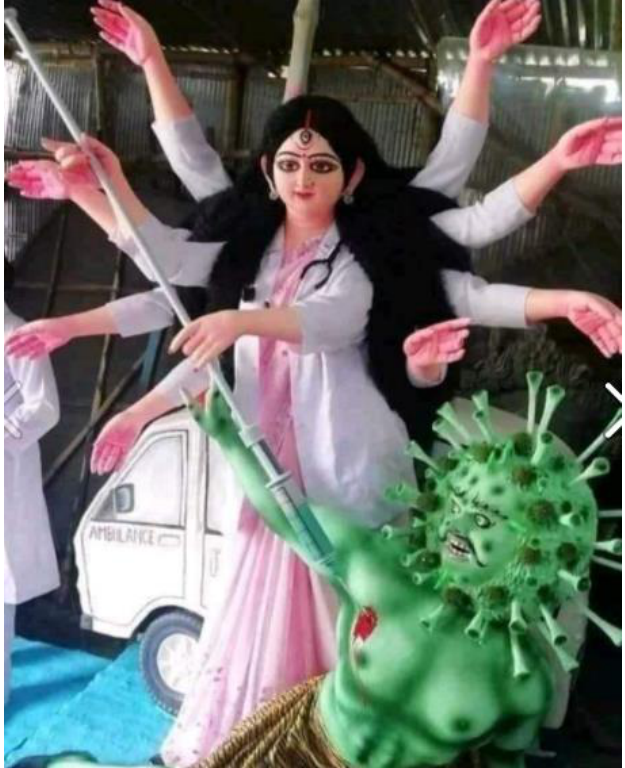
Figure 2. Mahi ṣ āsurmardhinī as a doctor in the Durgā Pā ṇḍ āl killing Coronāsur in place of the tra- ditional Mahi ṣ ā sur.(Source:https://www.face- book.com/photo.php?fbid=2458555707779360&set=a.1412237159077892&type=3&theater, accessed on 10 March 2022, 2: 07 PM).